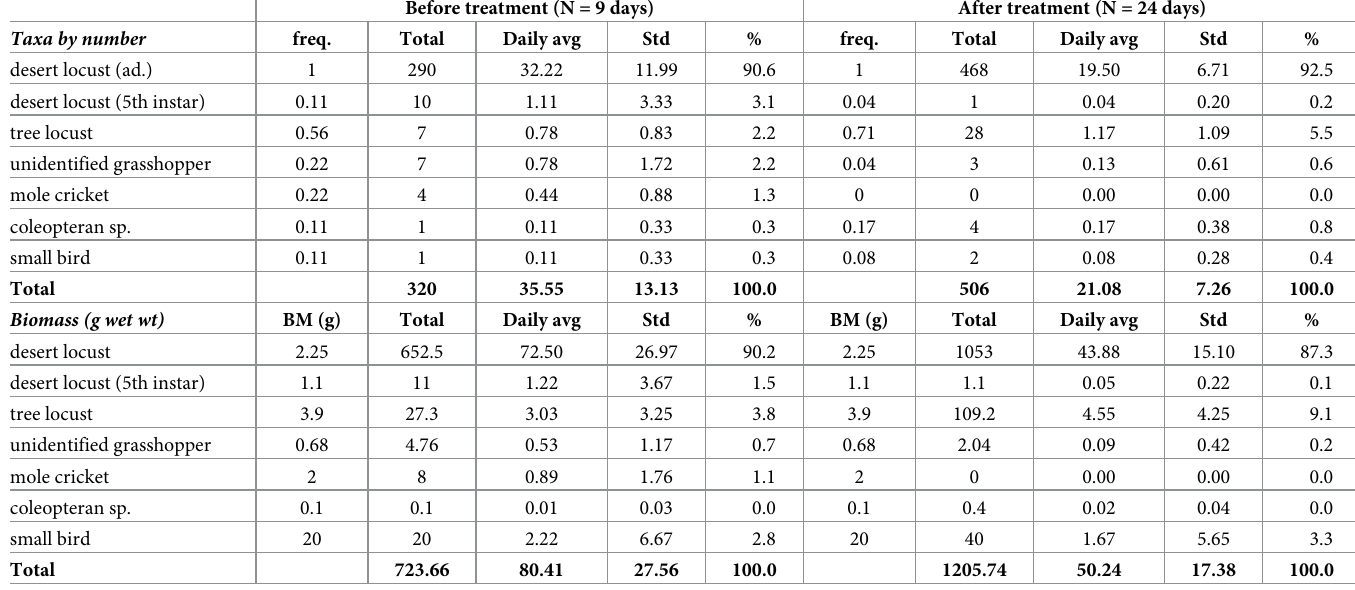
Table 4. Kestrel prey remains (including from pellets; see text) by number and their calculated biomass (as total wet wt) collected under KTREE1 and KTREE2 before (N = 9 days) and after (N = 24 days)